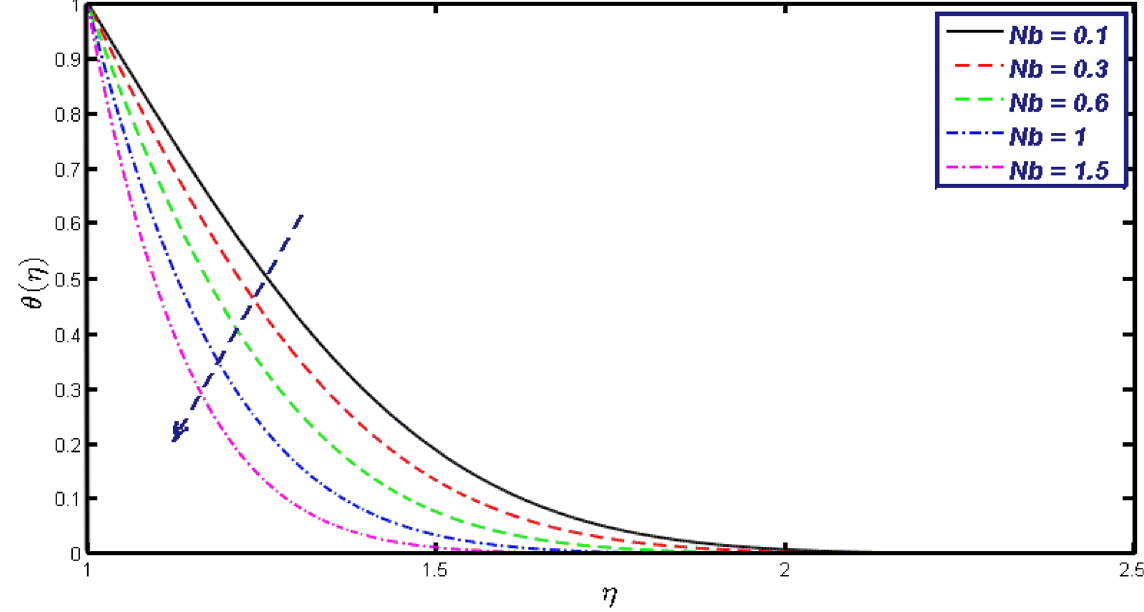
Figure 11. θ(η) field for different values of Nb .